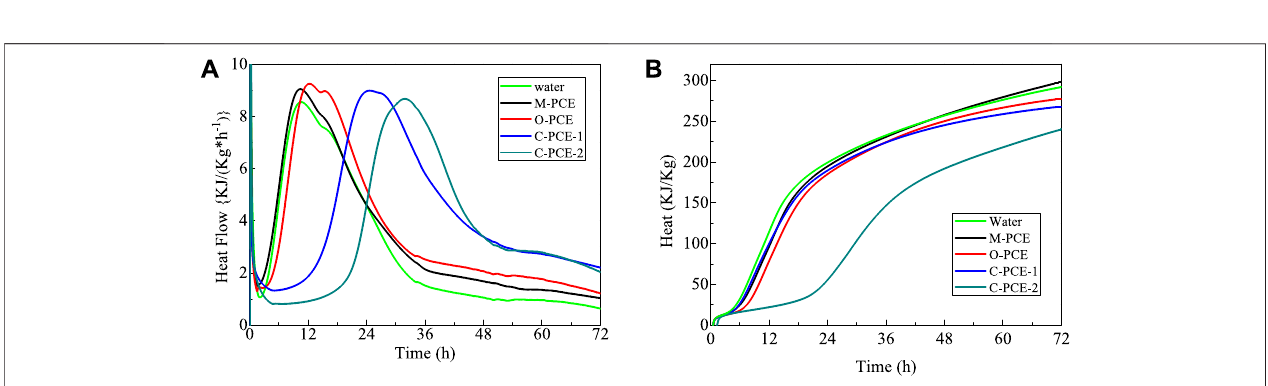
FIGURE 12 | In fl uence of polycarboxylate on the hydration of cement pastes: (A) heat evolution and (B) hydration heat.